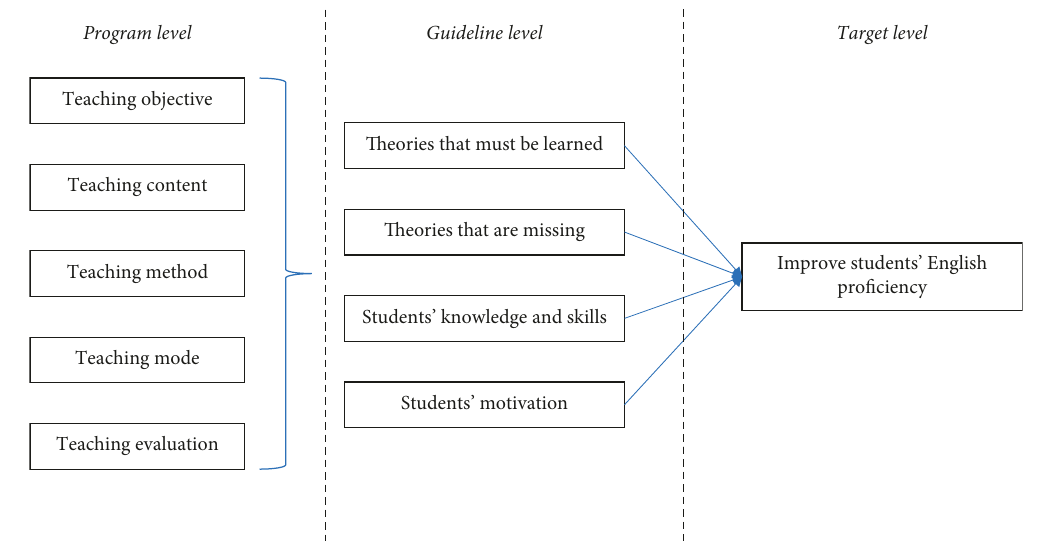
Figure 3: Hierarchical analysis chart. Table 1: Result of reliability and validity tests.